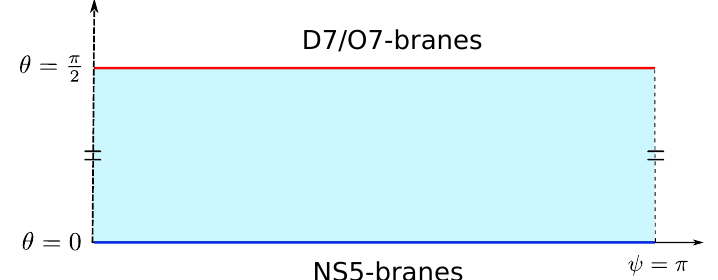
Figure 1 . The annulus for the Abelian T-dual background. NS5-branes are smeared along the lower boundary at (cid:18) = 0, and D7/O7 branes are smeared at the upper boundary at (cid:18) = (cid:25)= 2. The annulus topology follows from the periodicity under ! + (cid:25) , or w ! w + 1,